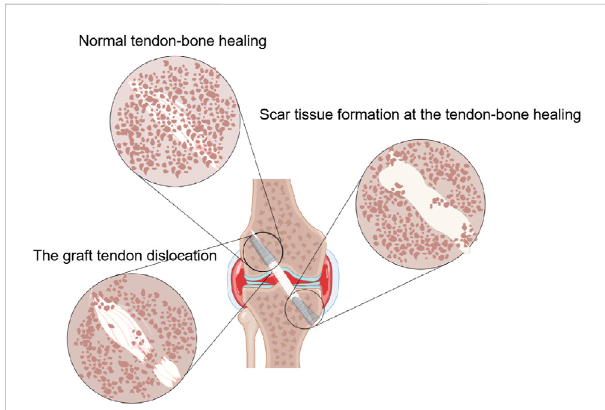
FIGURE 1 Theoutcomeoftendon-bonehealingispresentedbyFigdraw.In normal tendon-bone healing, the transplanted tendon will eventually be fully ossi fi ed in the bone tunnel. Scar tissue formation at the tendon-bone healing interface will result in poor mechanical properties. Secondly, failure of graft tendon fusion in the bone tunnel will lead to graft dislocation.